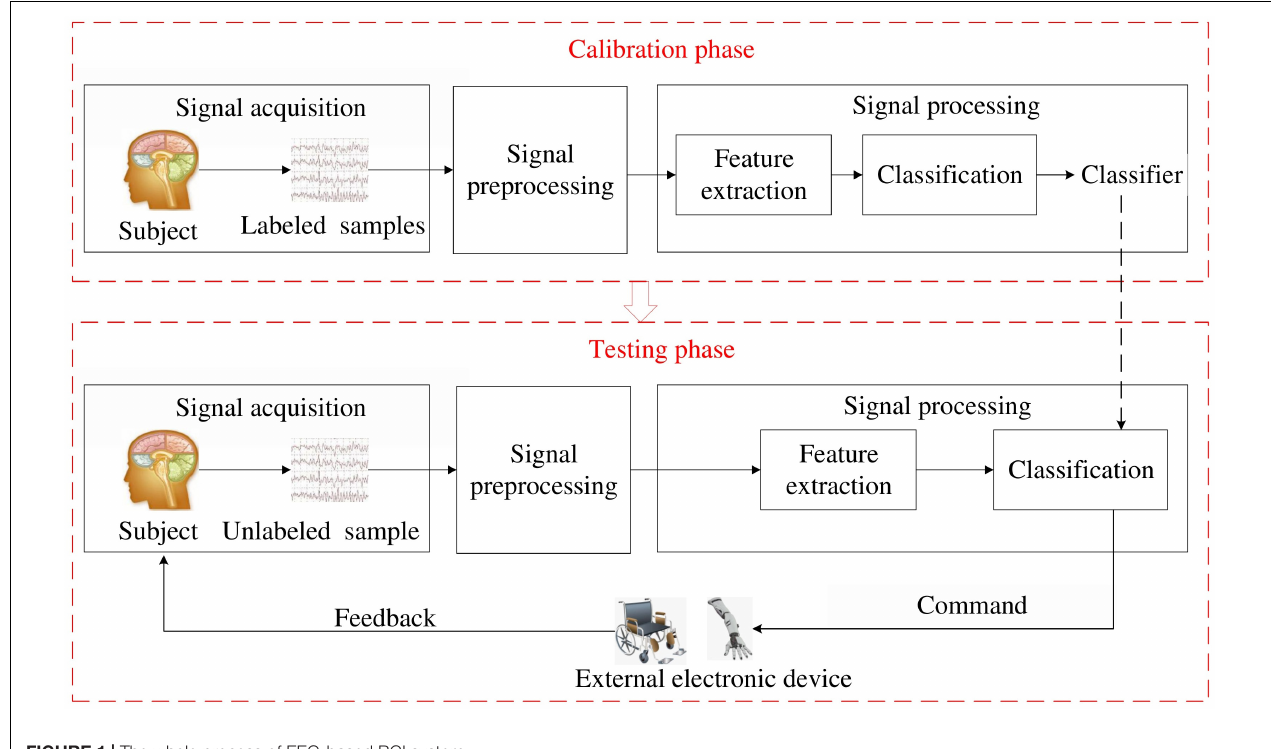
FIGURE 1 | The whole process of EEG-based BCI system.